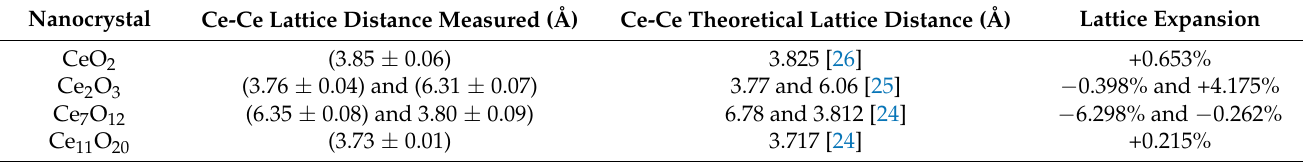
Table 5. The Ce lattice distance of nanoceria extracted from S6NBCe4 glass compared with the theoretical